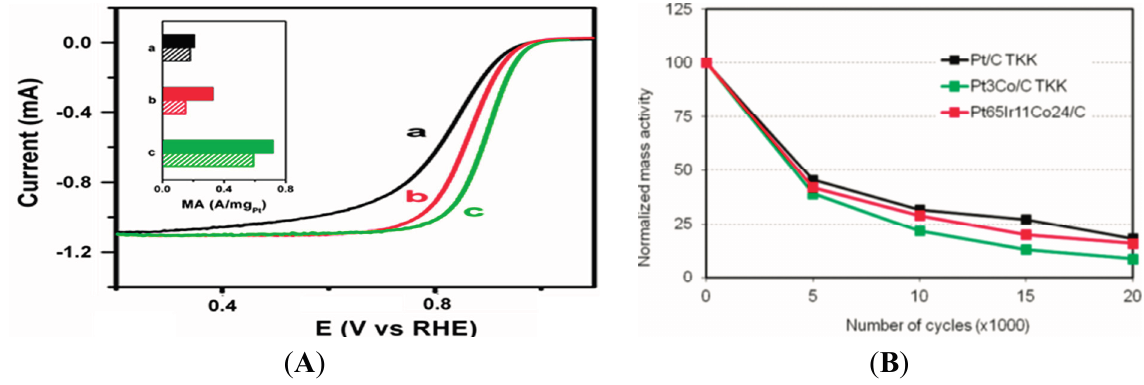
Figure 5. Electrocatalytic activities for ORR in O 2 -saturated 0.1 M HClO 4 : ( A ) RDE curves for 400 °C (solid bar) and 800 °C (dash bar) treated catalysts: Pt 45 Ir 55 /C ( a ), Pt 73 Co 27 /C ( b ), and Pt 25 Ir 20 Co 55 /C ( c ). Insert: Mass activities extracted from RDE curves for the same catalysts. ( B ) Durability plots of normalized mass activities as a function of the number of potential cycles (ranging from 0 to 20,000 cycles) for different catalysts upon potential cycling (( A ) reproduced from reference [15] with permission. Copyright 2013, American Chemical Society, ( B ) reproduced from reference [34] with permission. Copyright 2012, American Chemical